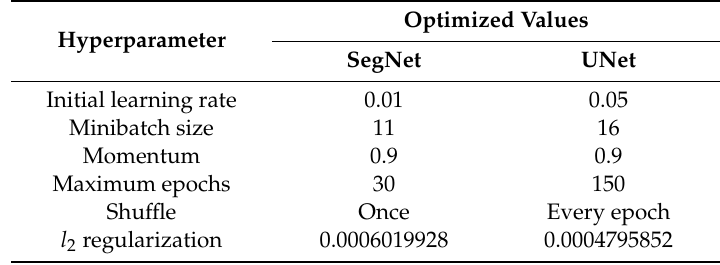
Table 4. The optimized hyperparameters for segmenting livers and liver lesions using SegNet and UNet, respectively.